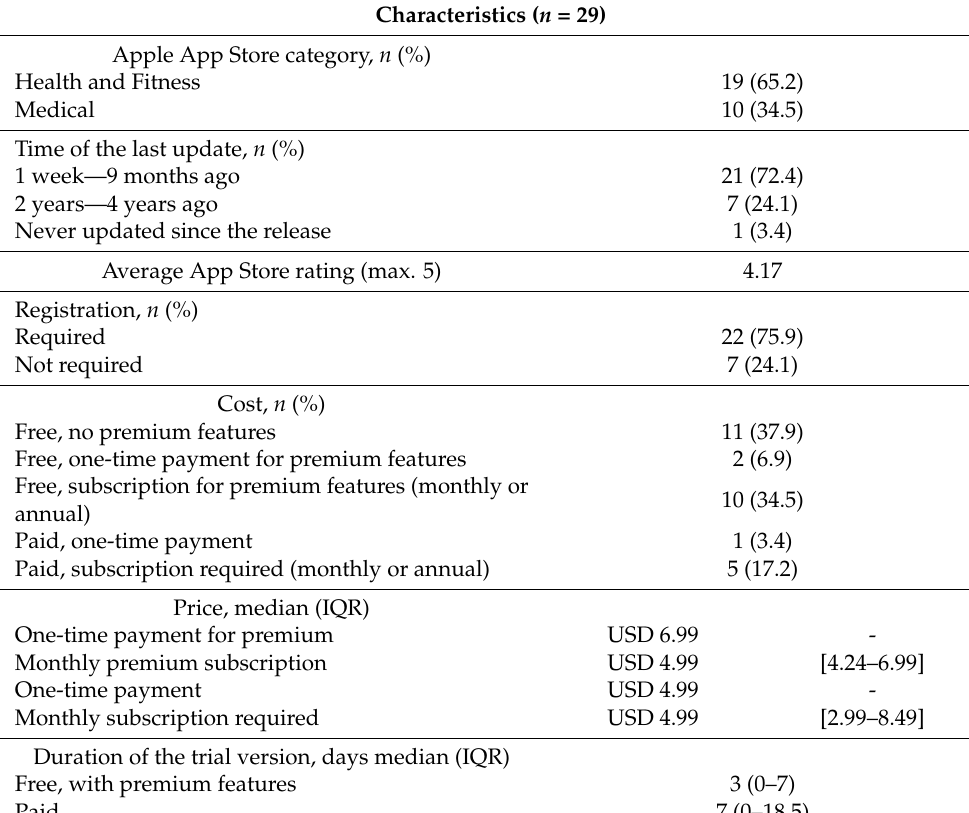
Table 1. Overview of mHealth apps included in the